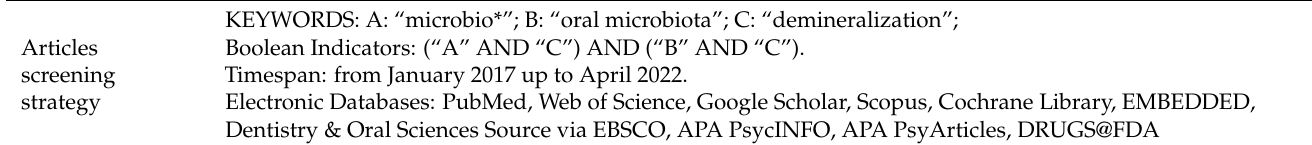
Table 1. Database search indicators.